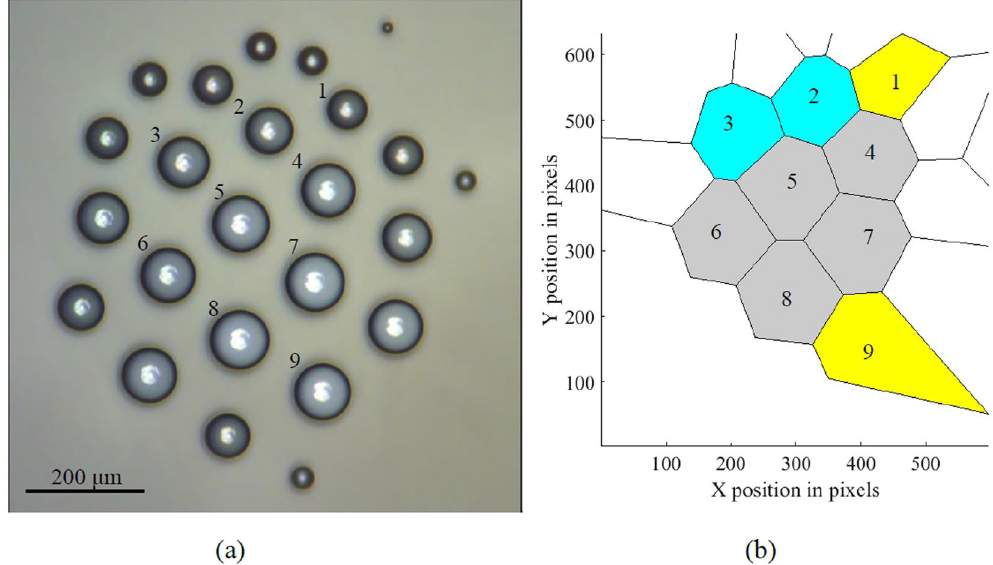
Figure 2. Self-organization of a droplet cluster. ( a ) The image of the cluster and ( b ) the Voronoi tessellation of the cluster. Yellow (1,9), gray (4–8), and blue (3,2) polygons have five, six, and seven neighbors,